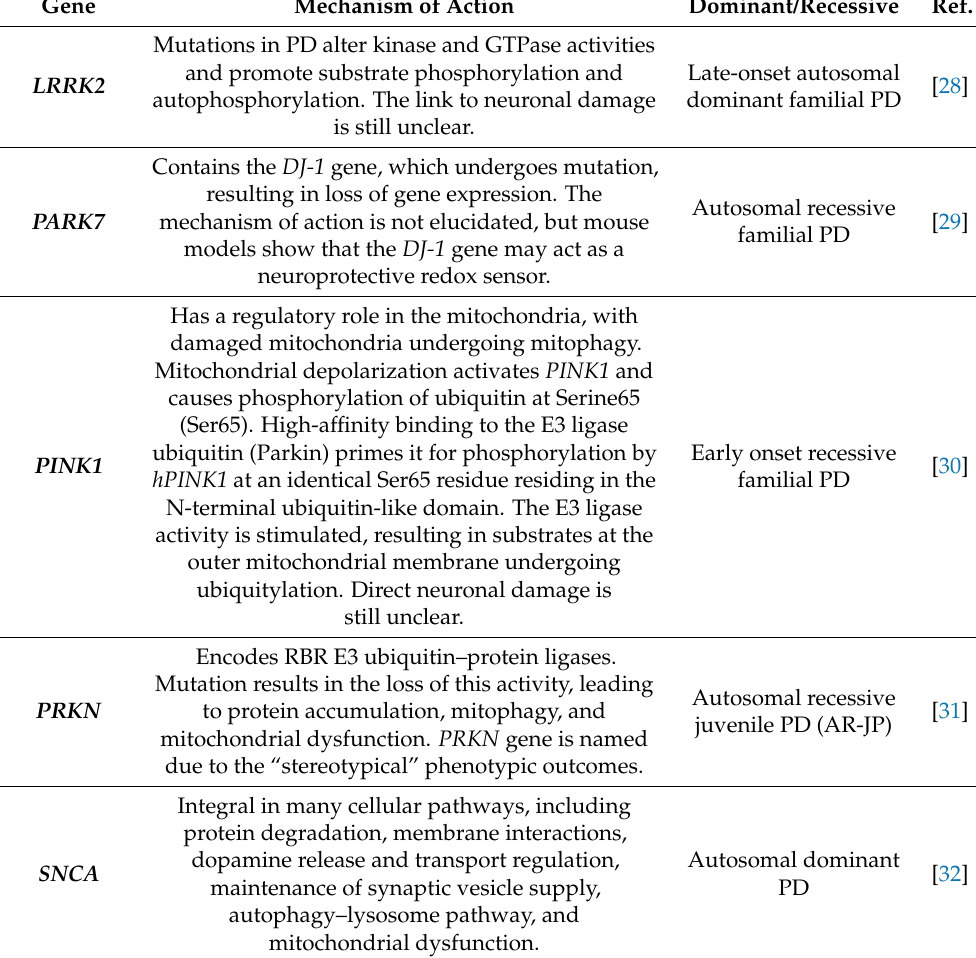
Table 1. Genes commonly implicated in the onset of Parkinson’s